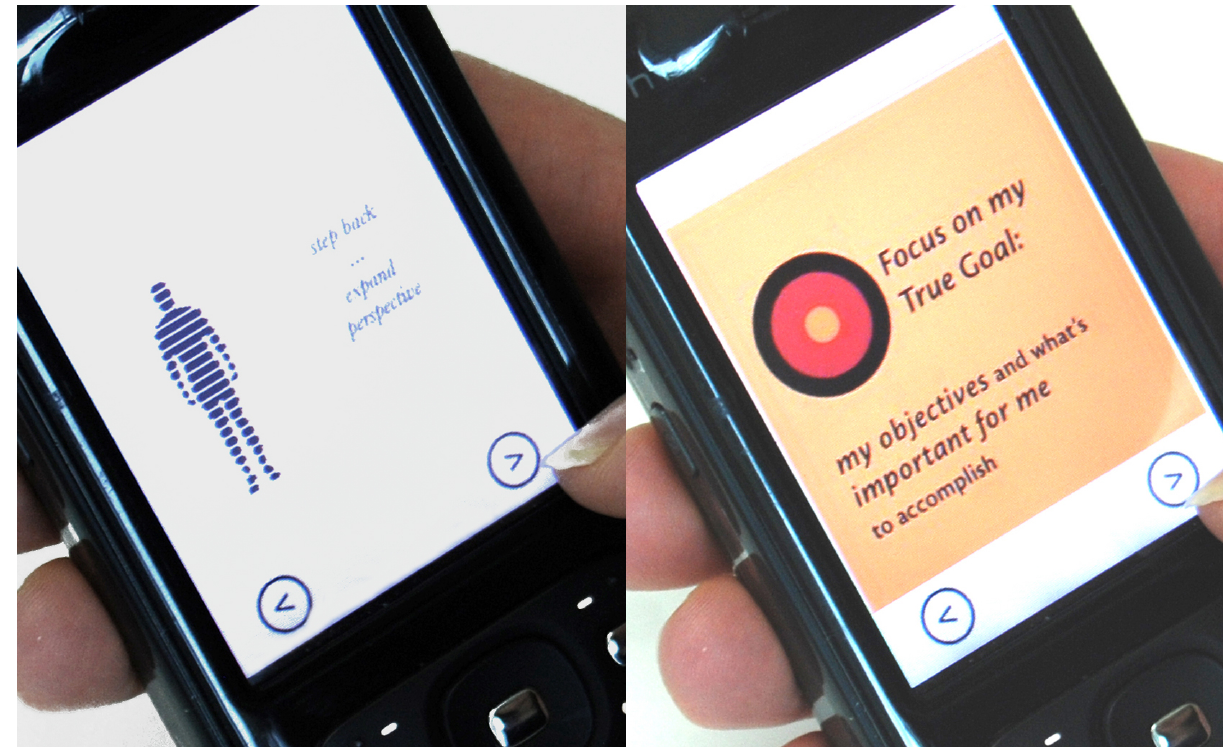
Figure 10. Forest and other participants quickly internalized the mobile therapies.